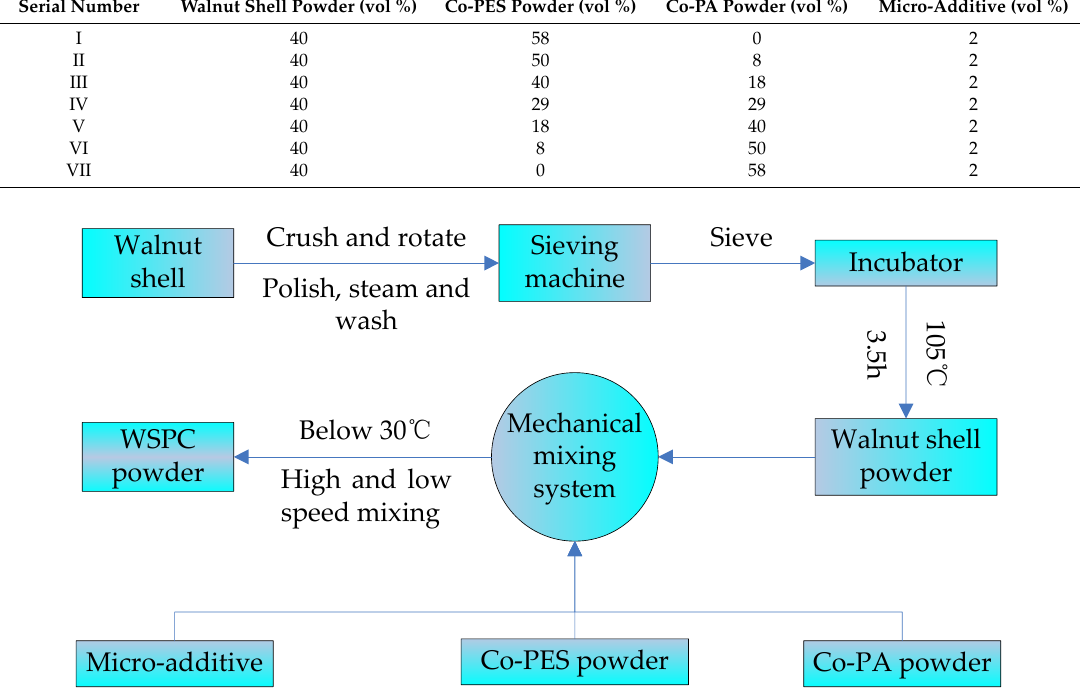
Figure 2. The process flow chart for the preparation of the WSPC powder.